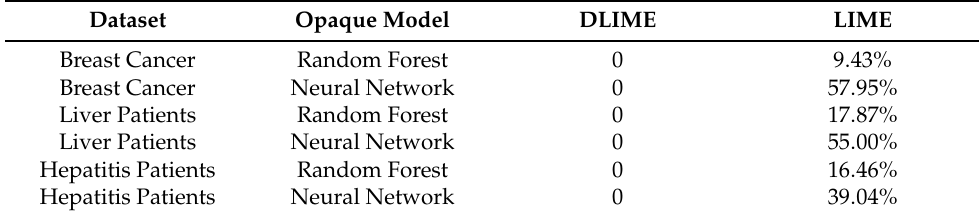
Table 2. Average FSI after 10